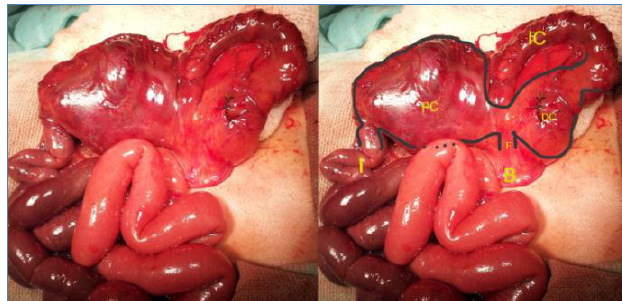
Figure 2: Operative photograph shows proximal and distal colonic pouches with intervening colon.(Left- unedited; right- edited with markings). PC: Proximal pouch, DC: Distal pouch, I: Ileum, B: Bladder, F: